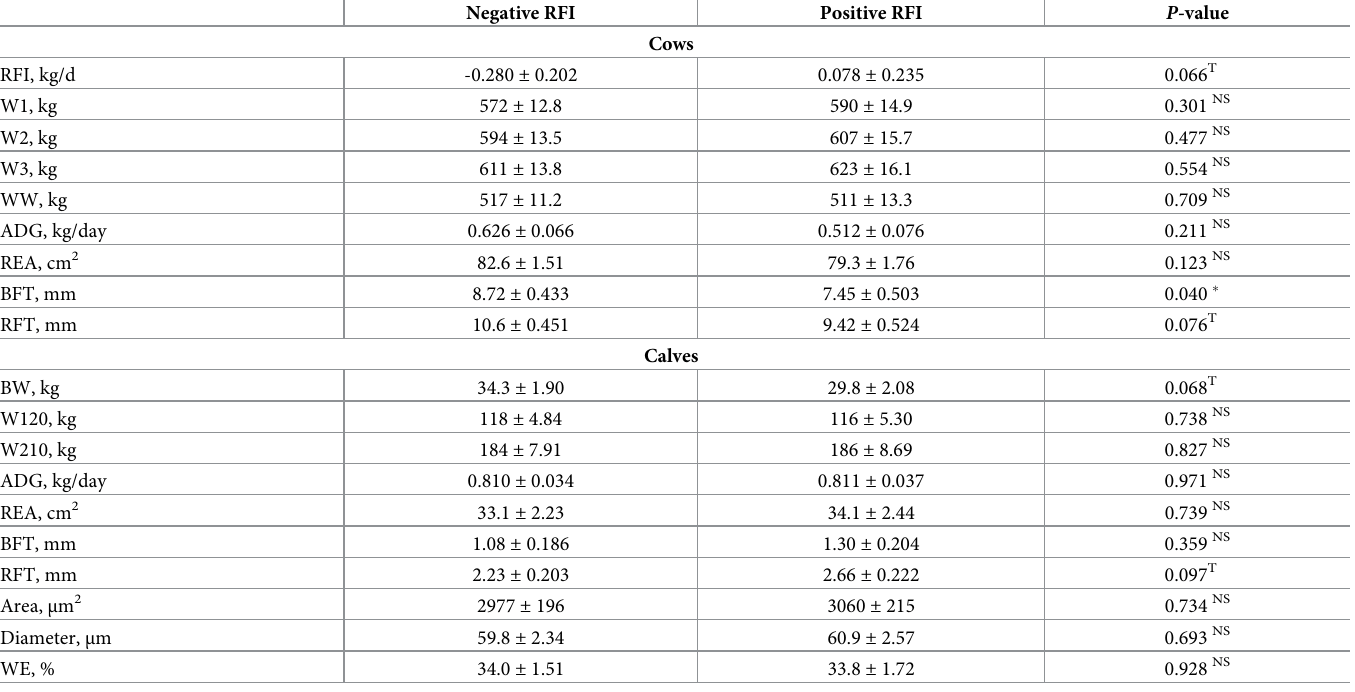
Table 7. Performance of Nellore cows of different residual feed intake (RFI) classes during the second trimester of gestation and postnatal growth of their calves in Year